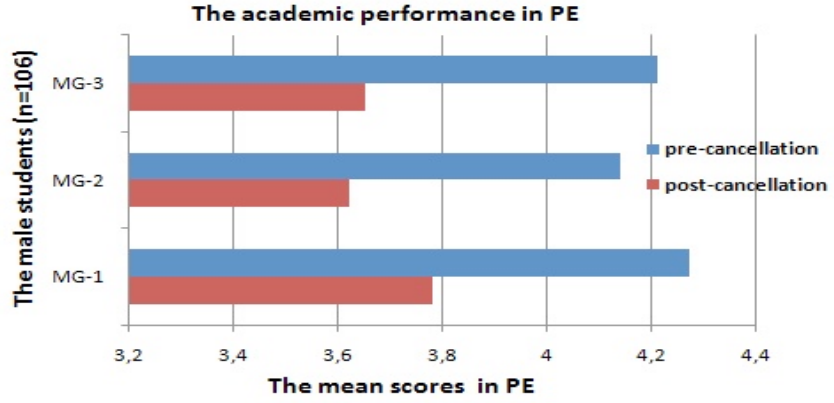
Fig. 1. The changes in academic performance in PE in male